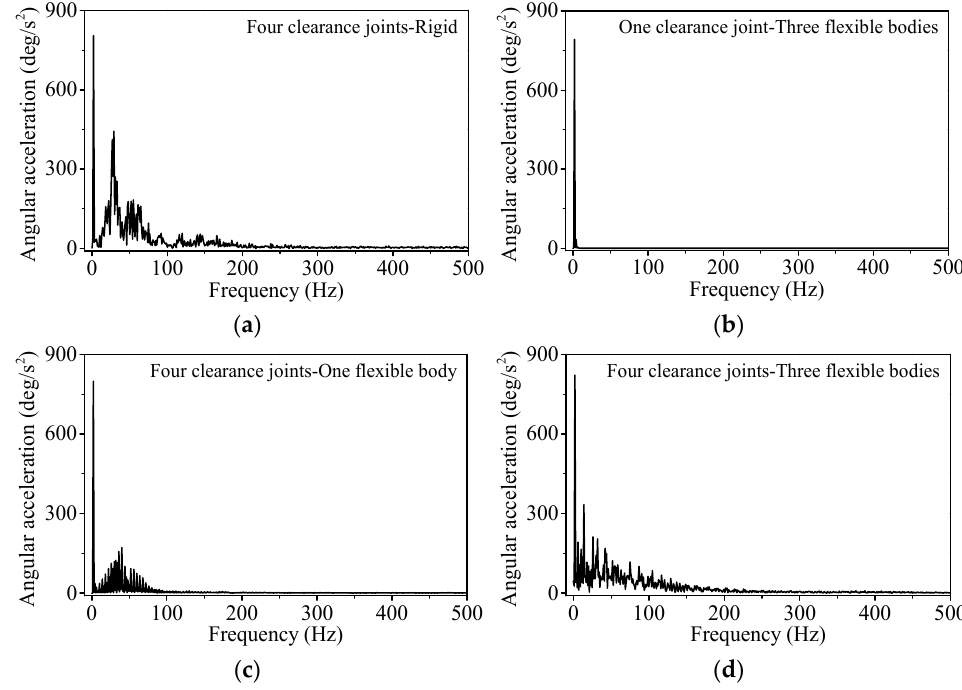
Figure 24. FFT analysis of the angular acceleration of shaft with different cases: ( a ) four clearance joints-rigid; ( b ) one clearance joint-three flexible bodies; ( c ) four clearance joints-one flexible body; ( d ) four clearance joints-three flexible bodies.